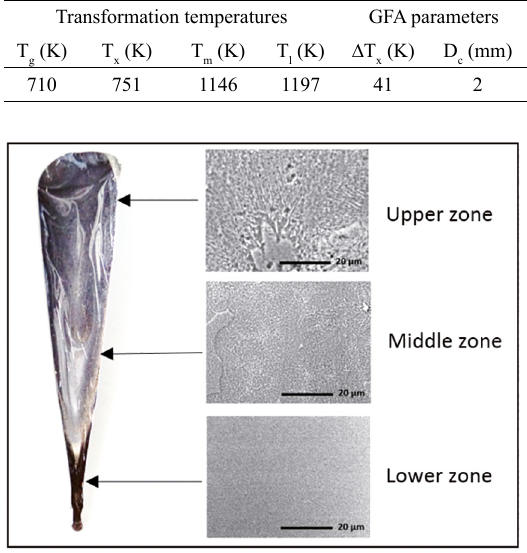
Figure 6: Conical ingot microstructures observed by scanning electron microscopy of the Zr